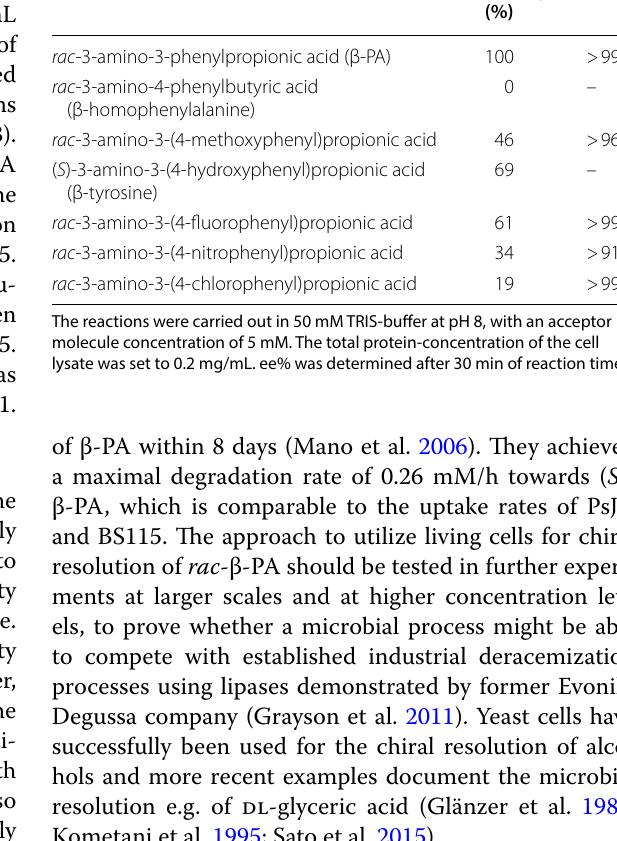
Table 2 Substrate spectrum of putative BS115 ω-TA